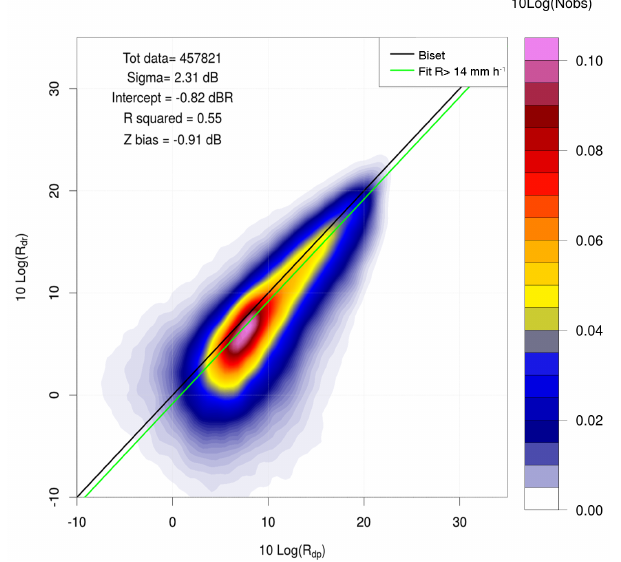
Figure 6. Self-consistency procedure applied on the Bric della Croce radar, 28 July 2014. The K dp -based rain rate, on a decibel scale, is shown in the x axis, and the rain rate based on Z and Z dr , on a decibel scale, in the y axis. The colors represent the density of data from blue (low density) to violet (high density), as reported in the color bar in logarithmic units using 1dBR intervals for both axes. The black and green line display the 1 : 1 line and the fit with slope set at 1, respectively, performed on the data with rain rate greater than 14mmh − 1 . The total number of data, the fit uncer- tainty, the intercept value (in dB), the correlation coefficient and the computed system bias are reported in the plot.